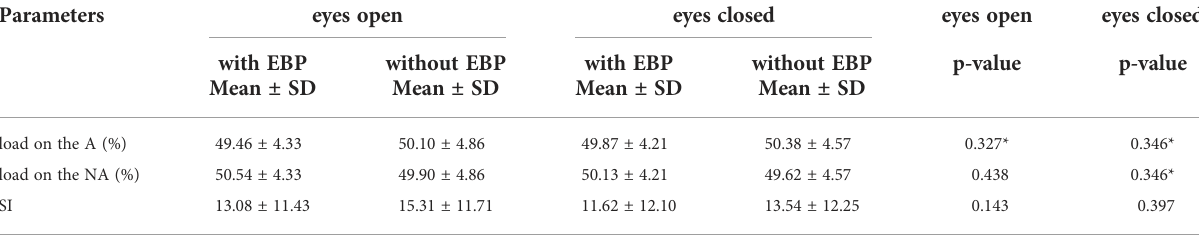
TABLE 4 Comparison of the weight-bearing distribution between the A and NA sides during the trial with and without the EBP while maintaining a free-standing position with the eyes open and closed (N = 52).